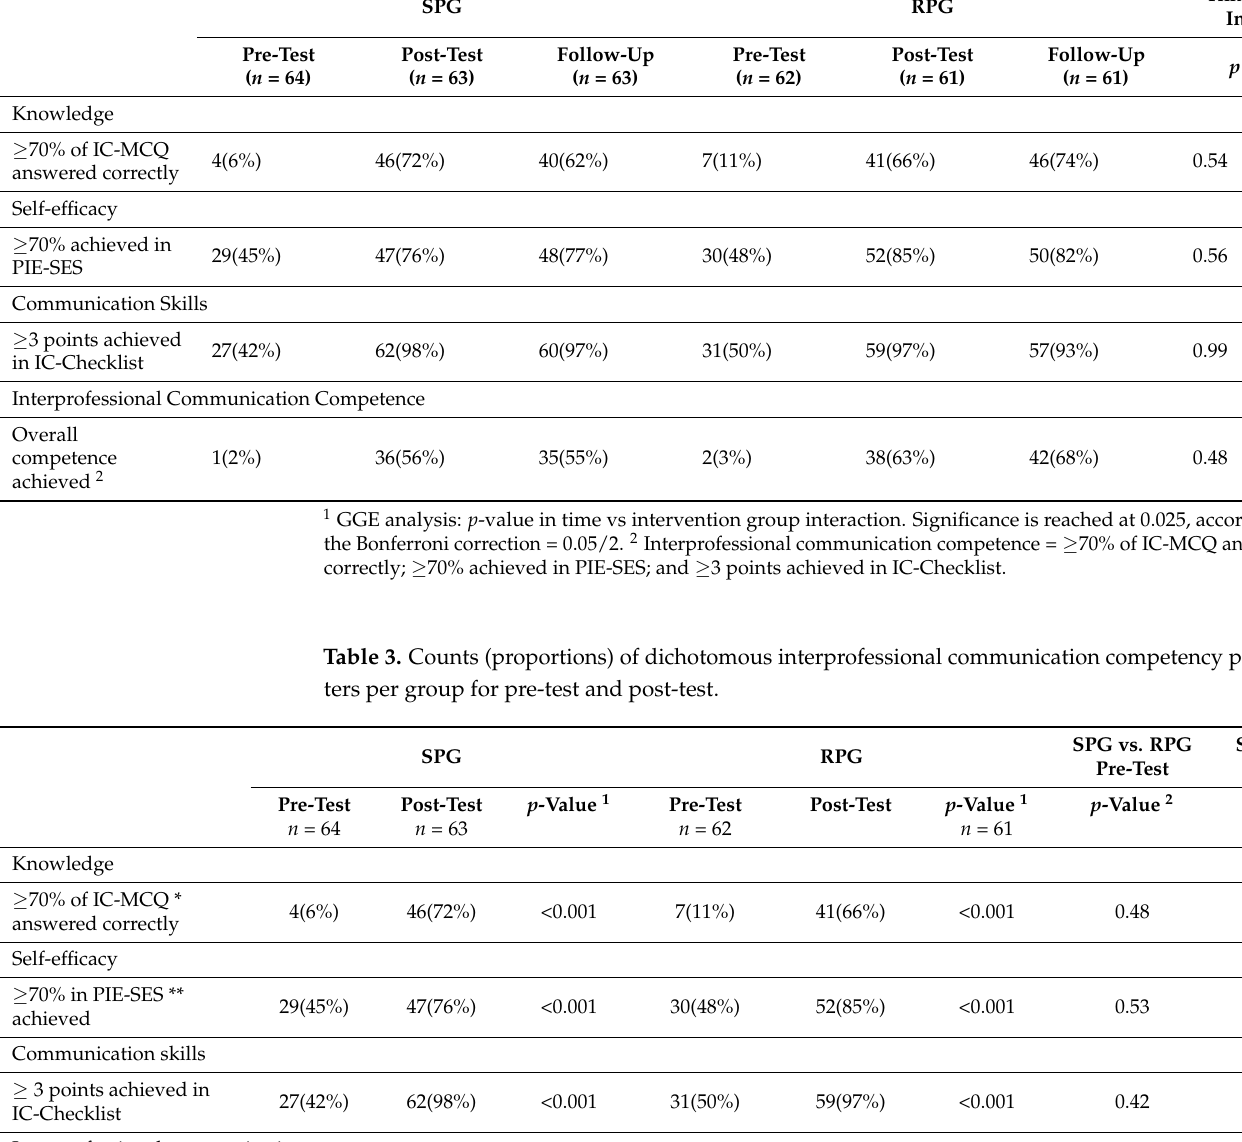
Time vs. RPG Int.